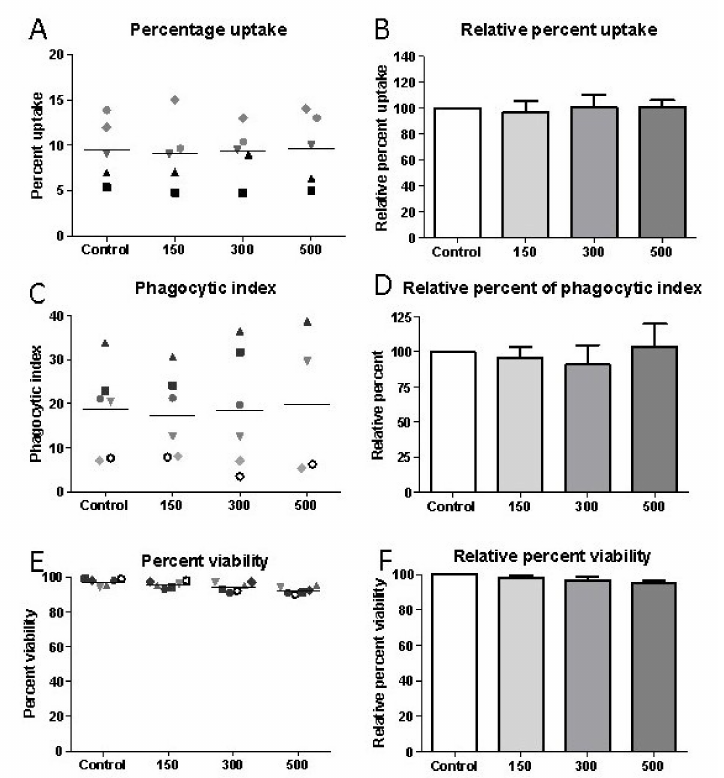
Figure 5. Shockwave stimulation does not up-regulate macrophage phagocytosis of the non-specific substrate, polystyrene beads. Macrophages were exposed to shockwave intensities of 150–500; 5 Hz, 0.1 mJ/mm 2 then cultured with polystyrene beads. ( A ) Percentage uptake and ( B ) relative percent- age uptake over control macrophages without shockwave exposure of polystyrene beads by J774 macrophages. ( C ) Phagocytic index and ( D ) relative percent phagocytic index over control J774 macrophages without shockwave exposure for uptake of polystyrene beads. Data plotted represent individual values as illustrated by the individual symbols ( A , C ) and the normalized data deter- mining the relative percentage of shockwave exposed cells to non-exposed control cells for each cell preparation ( B , D ). ( E ) Percentage of viable J774 macrophages where symbols represent individ- ual values from different experiments and ( F ) the normalized values where non-exposed control represents 100%. Data shown as means ± SEM of independent experiments from 4–7 individual macrophage